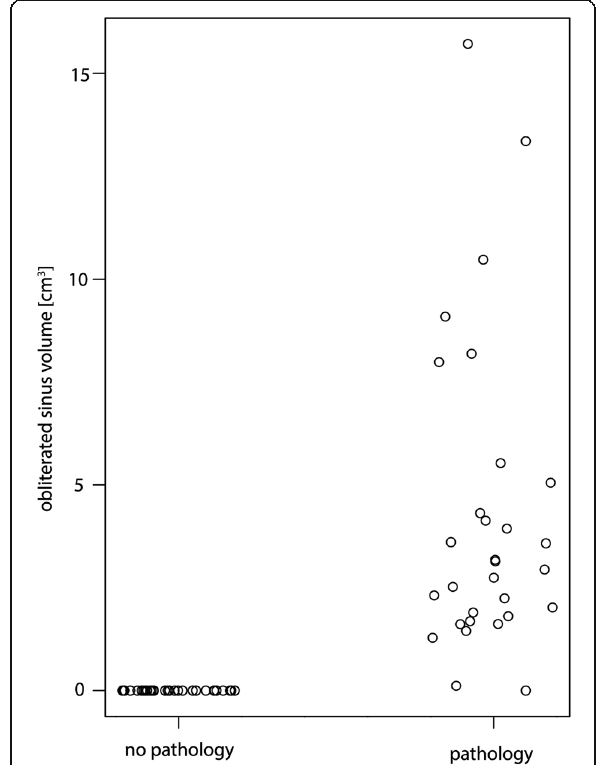
Fig. 5 The association between the obliterated volume and sinus pathology. The presence of a pathology significantly increased the obliterated volume of a maxillary sinus ( p < 0.001). For better visibility, the diagram has been jittered along the x